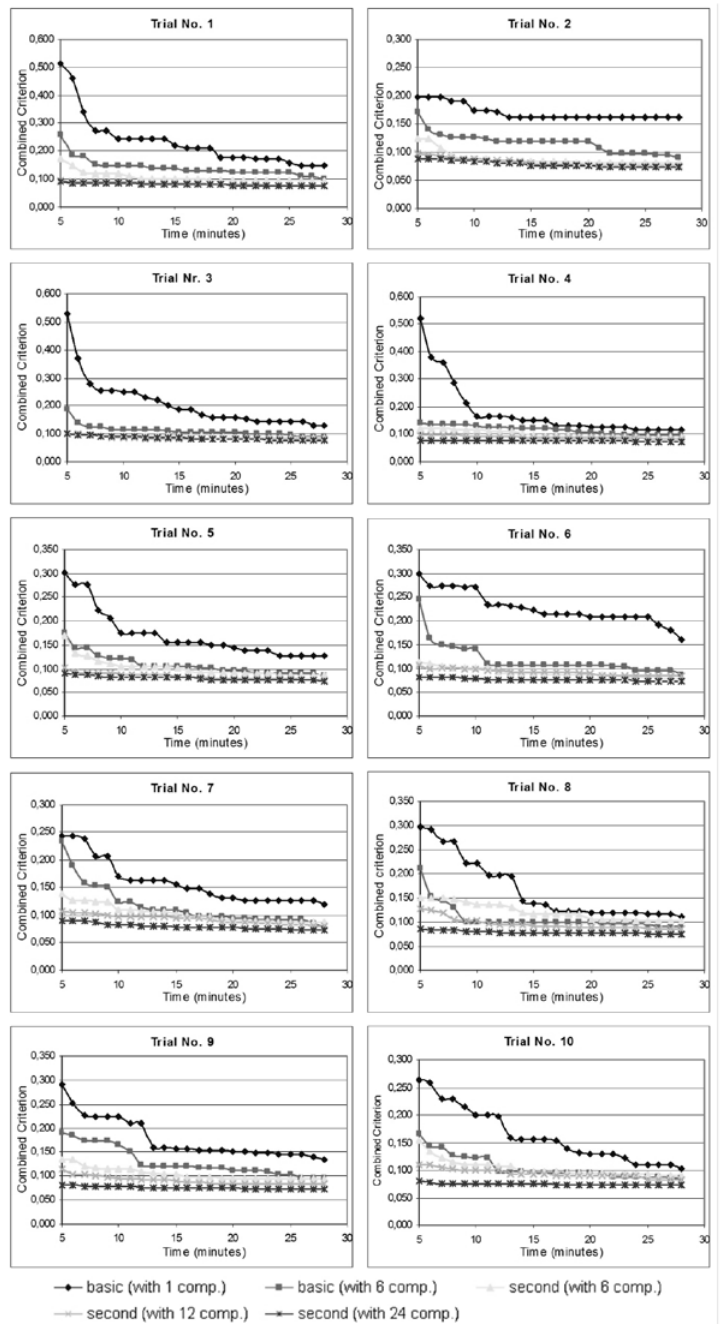
Fig. 5. Average values of the combined criterion of each